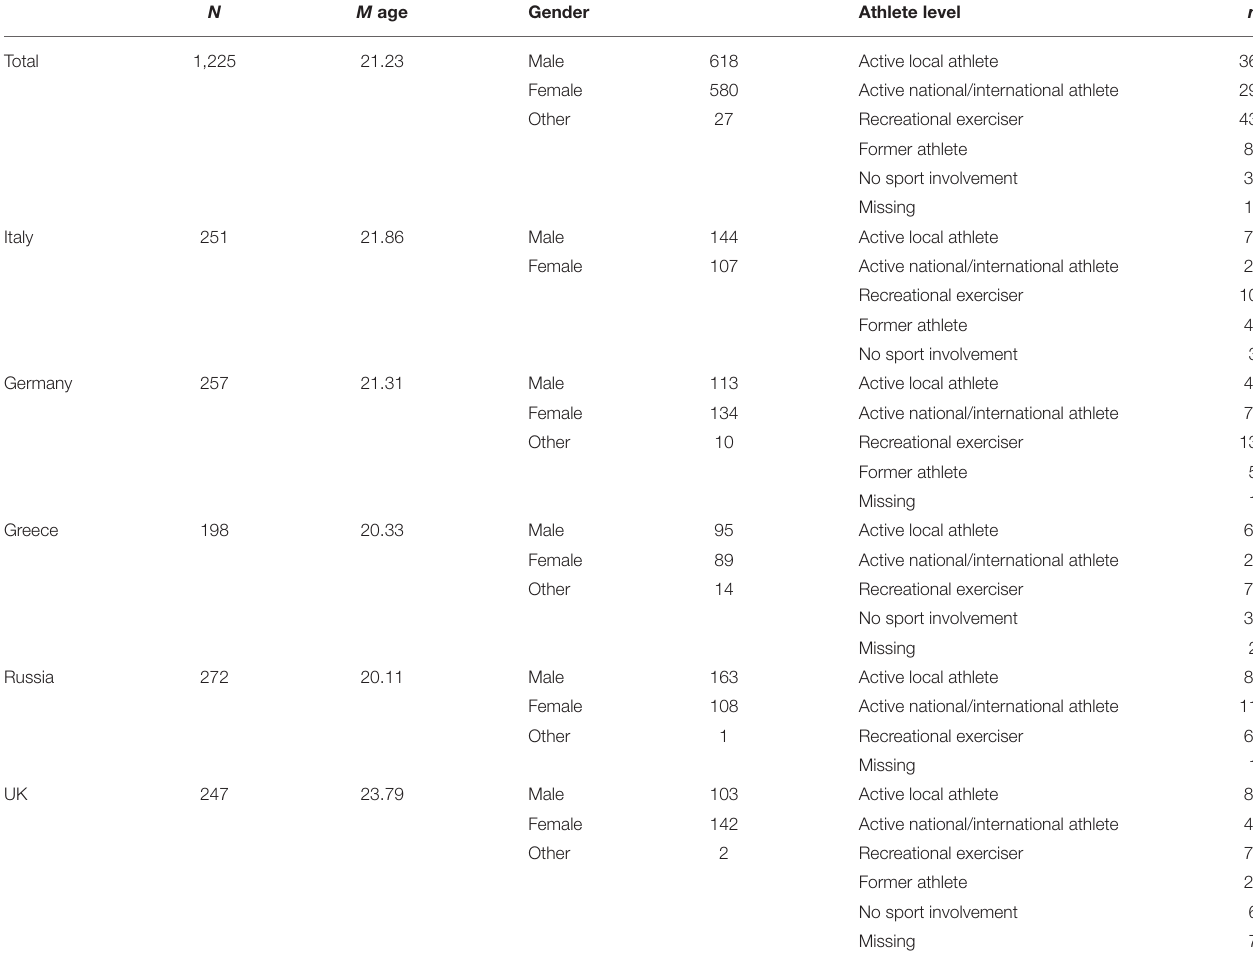
TABLE 1 | Participant